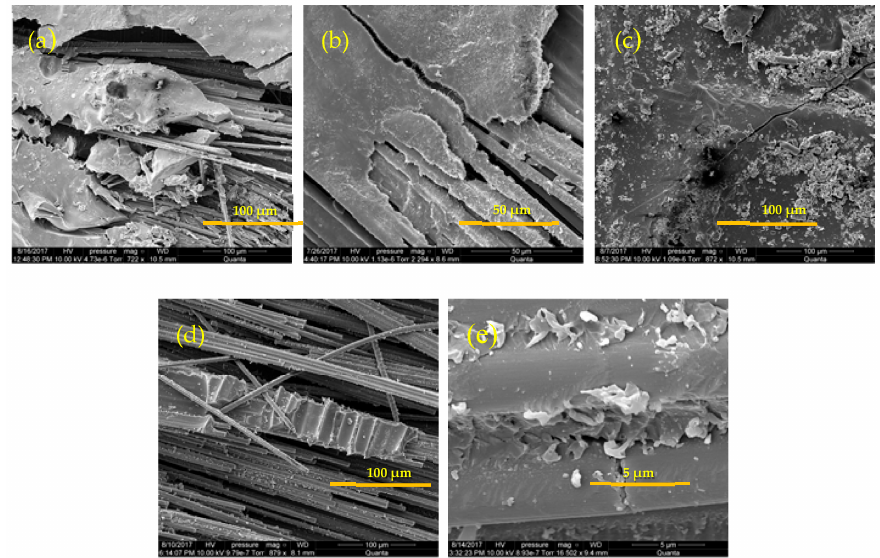
Figure 8. Micrographs of the fracture surfaces of the composites based on ( a ) CF and no BP no ZnO ; ( b ) CF and ZnO on BP; ( c ) ZnO on CF and no BP; ( d ) ZnO on CF, BP as is and ( e ) CF and BP as is no ZnO.